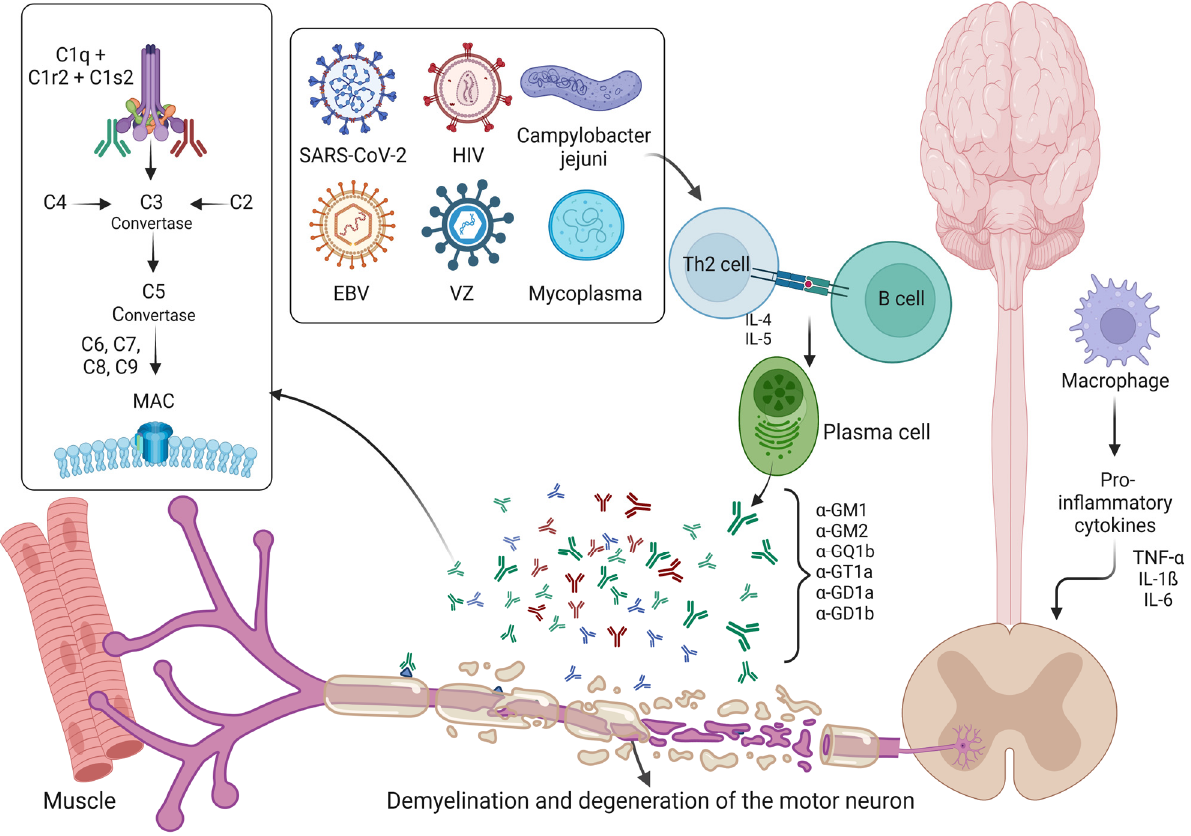
Figure 2. Immunopathological mechanisms involved in Guillain–Barre syndrome. A schematic diagram shows the various immunopathological mechanisms observed in Guillain–Barre syndrome. Preceding infection is usually observed, and this can involve various bacterial, viral and fungal pathogens. The subsequent activation of plasma cells and the molecular mimicry involving gangliosides, leading to destruction of myelin and axons, are shown. Proinflammatory cytokines too play a role in disease pathogenesis. The complement system is activated and is significantly involved in disease pathogenesis. Abbreviations: HIV: Human immunodeficiency virus; VZ: Varicella Zoster virus; MAC: Membrane attack complex.